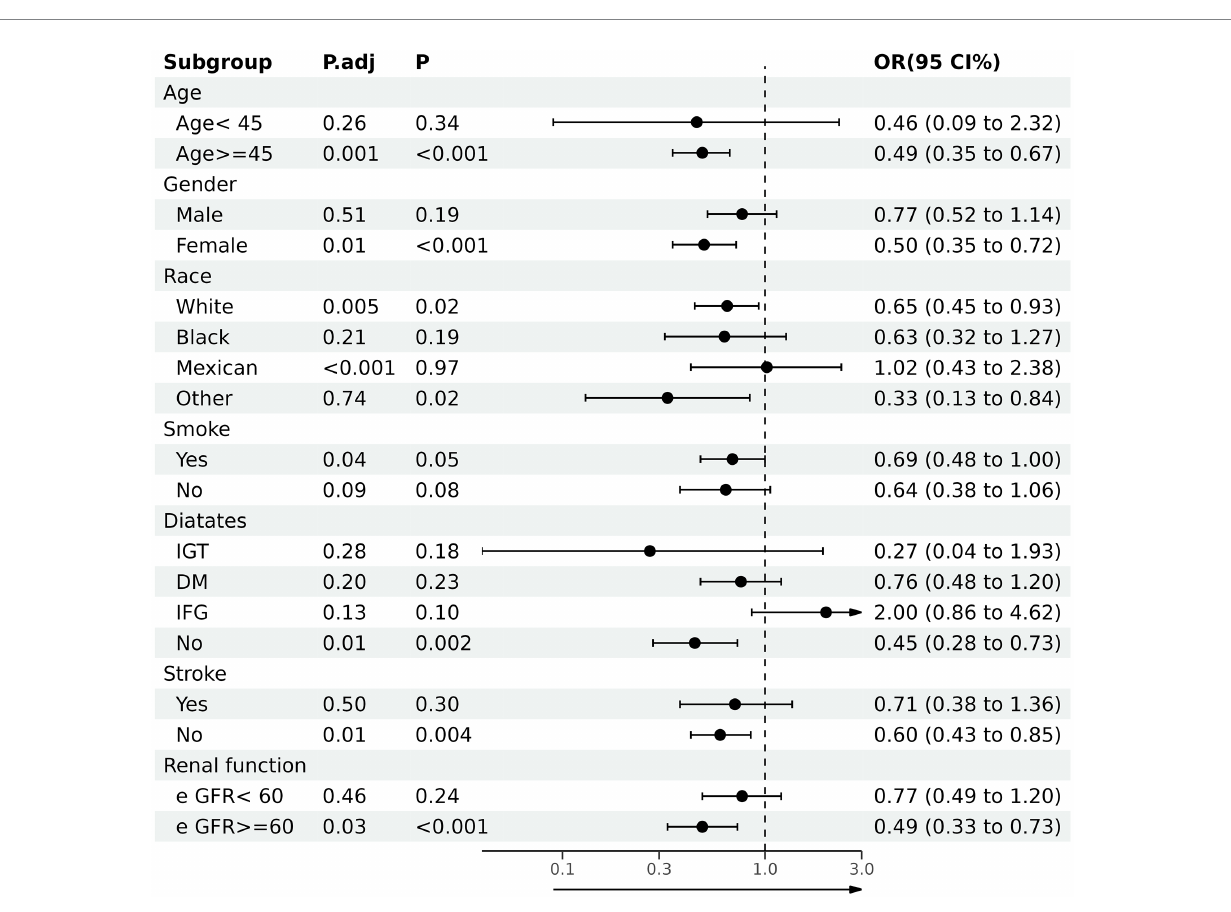
FIGURE 3 Association between total anthocyanidins (Q4) and heart failure in various stratifications. OR, odd ratio; CI, confidence interval; DM, diabetes mellitus; IFG, impaired fasting glucose; IGT, impaired glucose tolerance; eGFR, glomerular filtration rate.